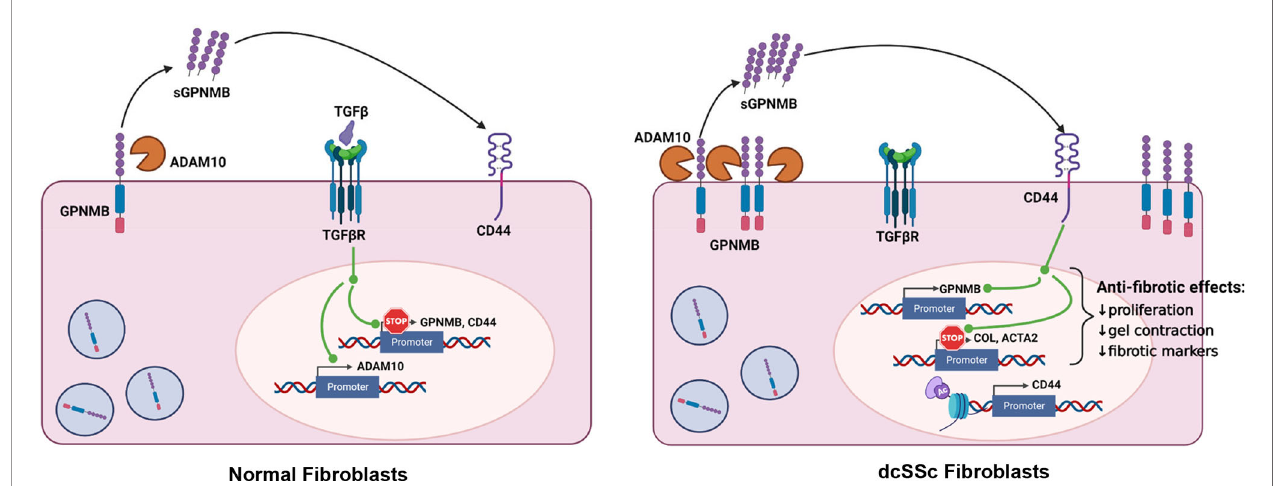
FIGURE 5 | Summary of this study. In normal fi broblasts, ADAM10 cleaves off the soluble form of GPNMB. TGF b downregulates GPNMB and CD44, and upregulated ADAM10. In dcSSc fi broblasts, increased amount of ADAM10 cleaves off high levels of sGPNMB, which acts through CD44, and subsequently downregulates COL1A1 and ACTA2 and exerts an anti- fi brotic effect. At the same time, sGPNMB forms a positive feedback loop to promote its own expression. CD44 appears to be modulated by histone acetylation in dcSSc fi